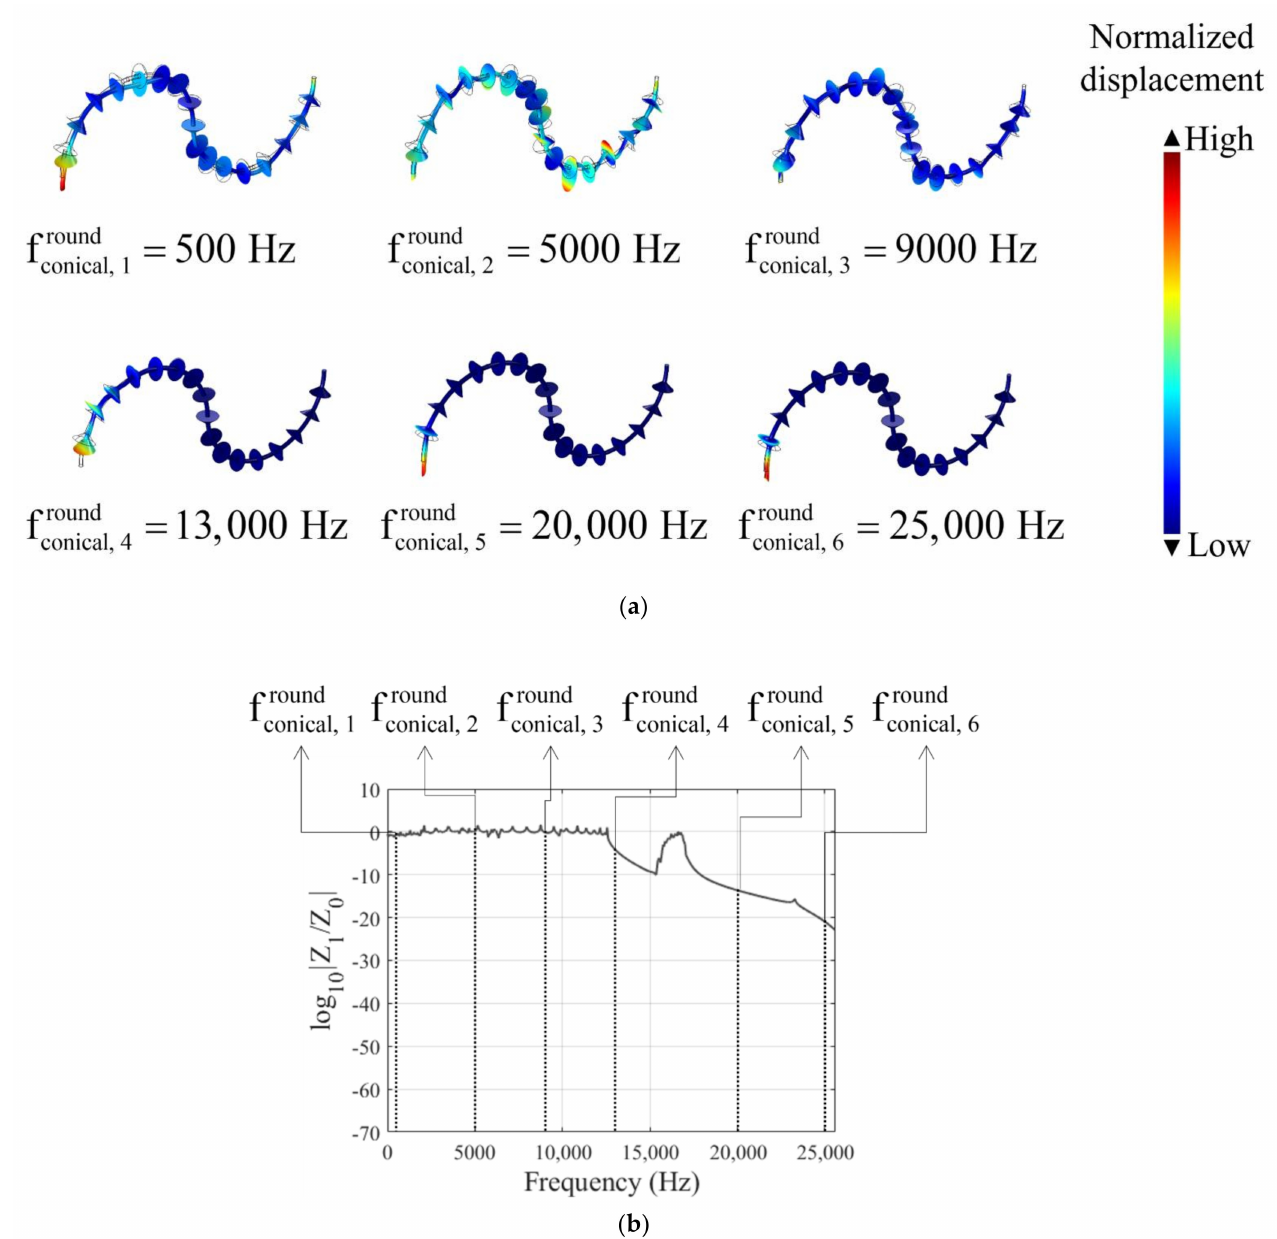
Figure 20. ( a ) Displacement at a specific frequency of the round conical metamaterials and ( b ) the frequency responses ( r p = 0.03 m, h p = 0.02 m )